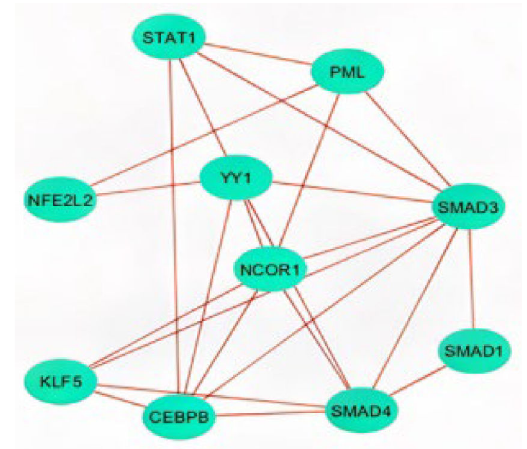
Figure 5. Interactome of top 10 transcription